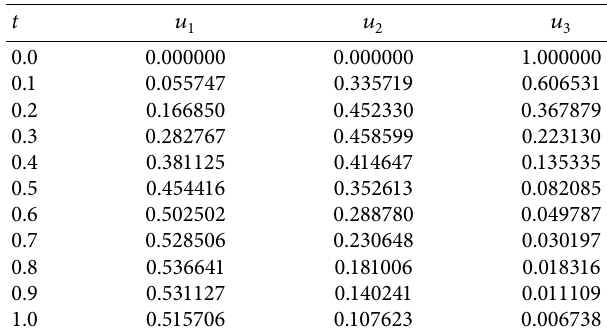
Table 3: Data generated for Example